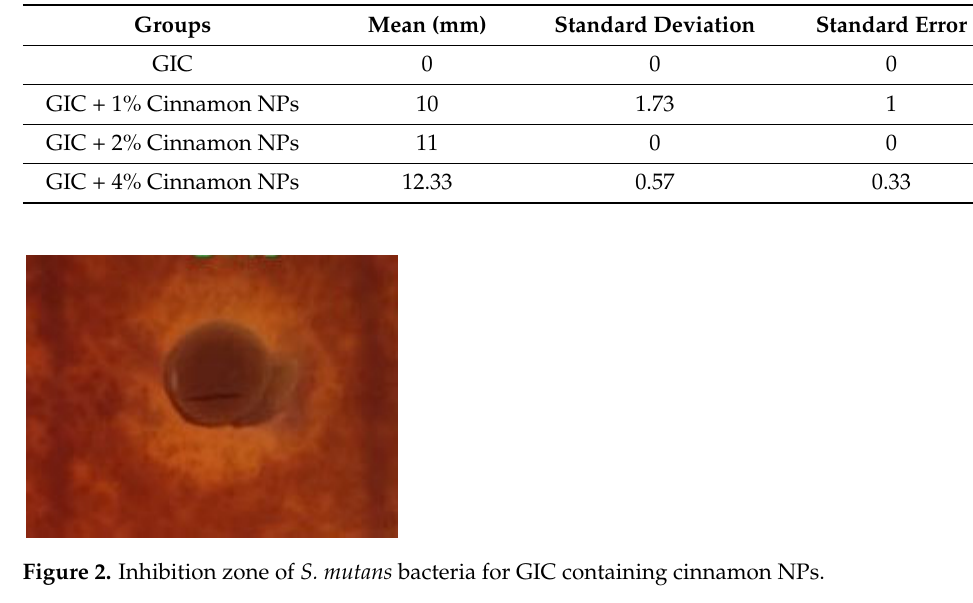
Table 1. Diameter of inhibition zone of S. mutans bacteria for GIC in in different weight percentages of cinnamon NPs.